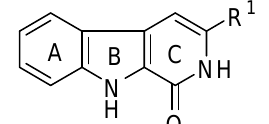
Figure 1. The structure of tricyclic β